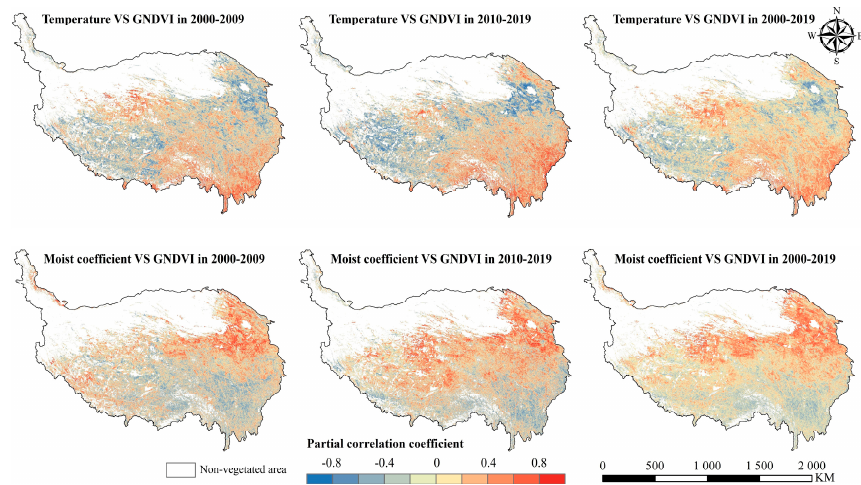
Figure 8. The spatial pattern of the partial correlation coefficient between the GNDVI and temperature and moist coefficient in the growing season on the QTP. Table 4. The areal proportion of different partial correlation levels in different study periods on the QTP (%).